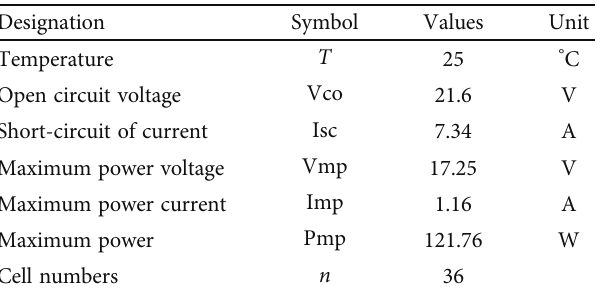
Figure 8: Flowchart of the SVM algorithm. Table 1: Technical speci fi cations of the Matlab 2020a